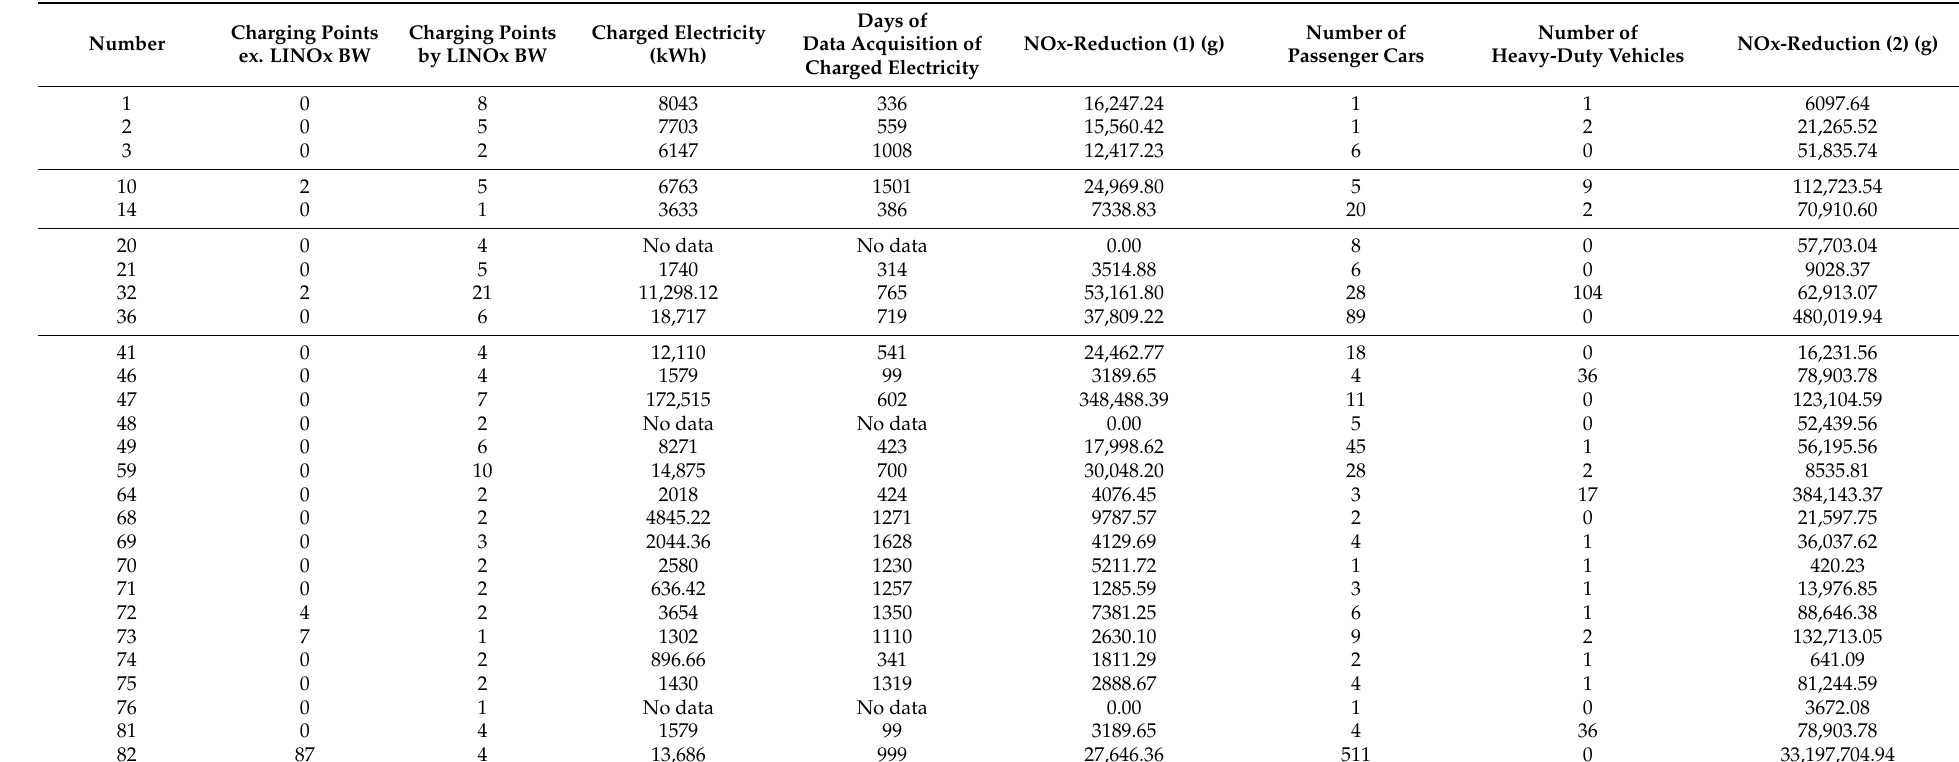
Table 5. Detailed information about the 27 valid cases for research concept